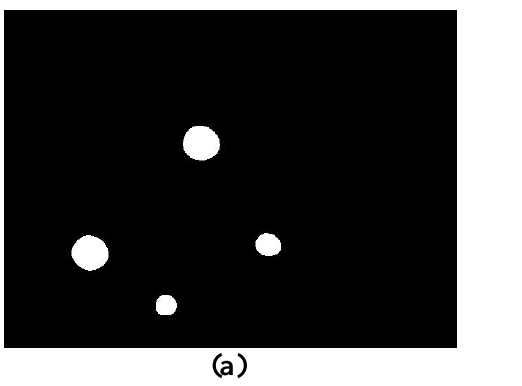
Figure 6. Results of performing the touching blob extraction process on the captured image in Figure 5. (a) Bright blobs extracted from Figure 5. (b) The connected-components of the bright blobs obtained from Figure